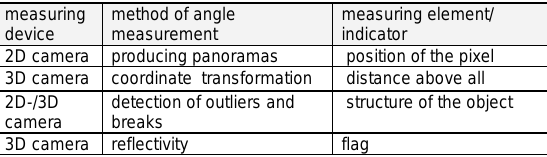
Table 3 methods for angle